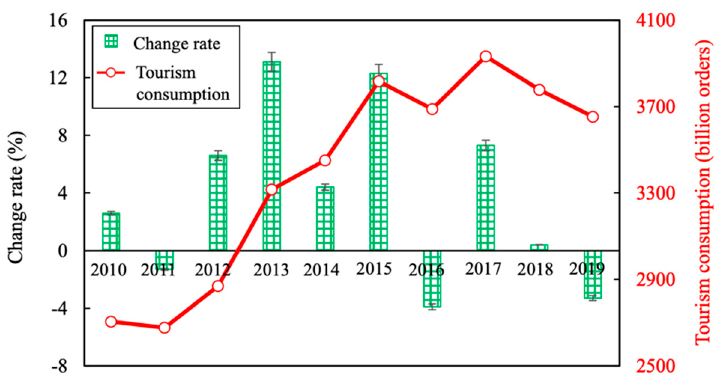
Figure 3. Tourism consumption and tourism consumption growth rate in Nagasaki Prefecture.